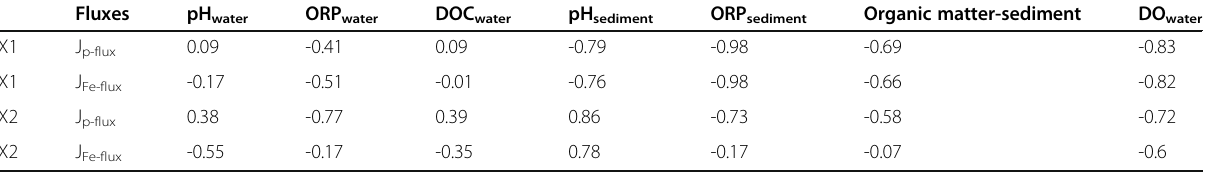
Table 1 Pearson ’ s correlation of Fe and P efflux with physico-chemical properties of Tianbao reservoir